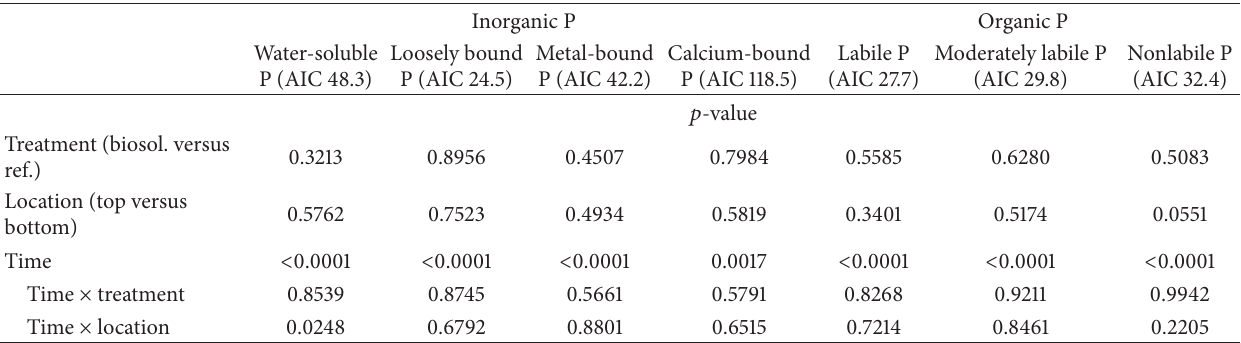
Table 1: Generalized linear mixed model (GLMM) results for various P